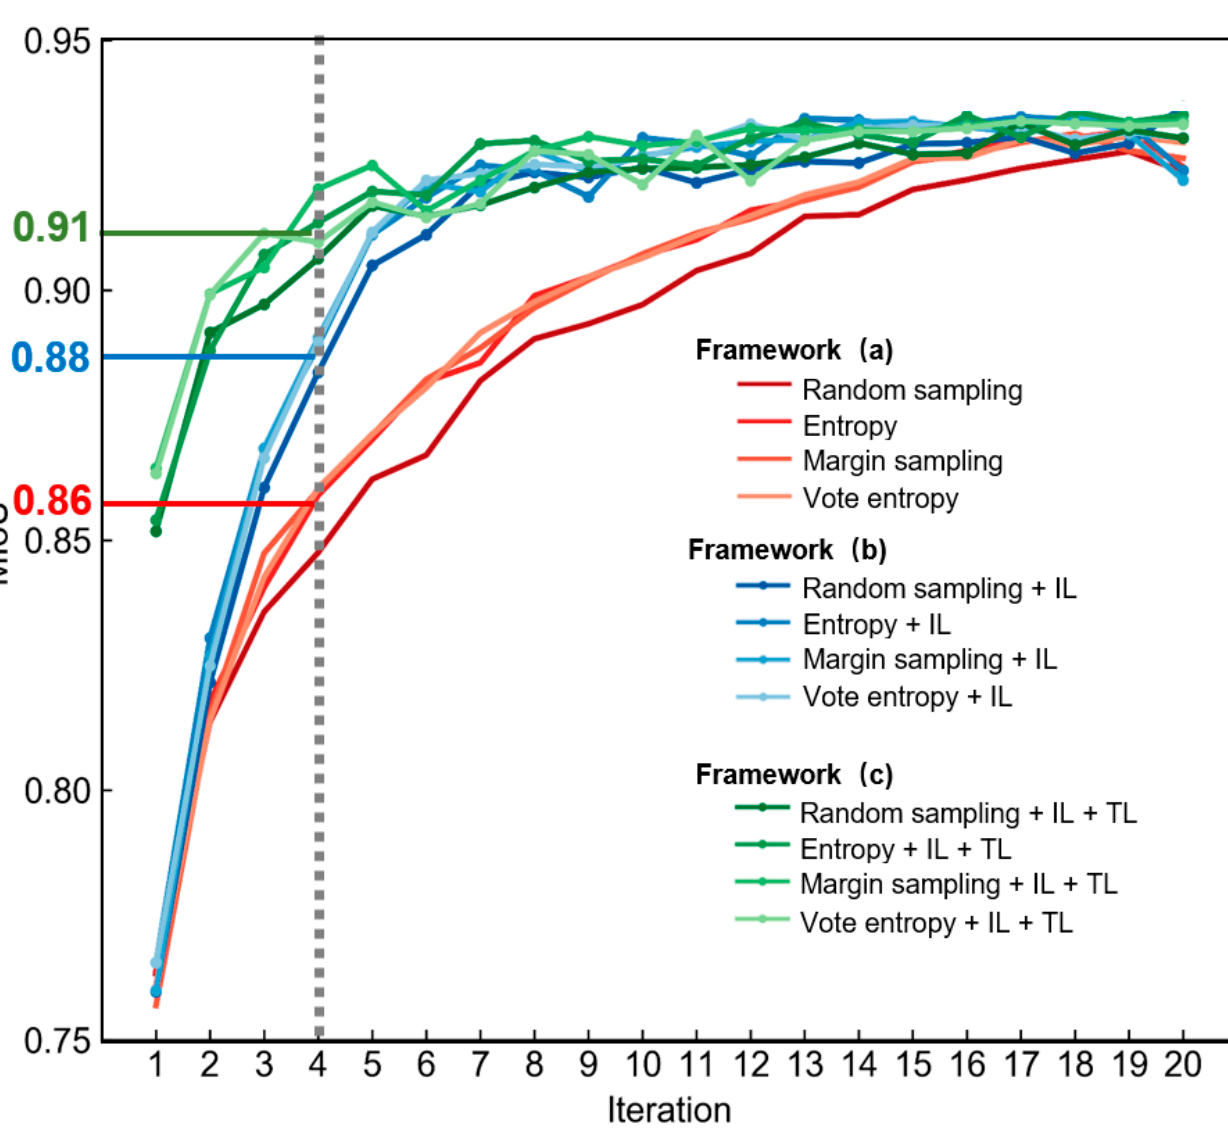
Figure 6. Comparison of performance of the three frameworks based on WHU aerial building dataset. The red lines indicate the mIoU value of DeeplabV3+ in each iteration derived from framework ( a ), the blue lines indicate the mIoU value of DeeplabV3+ in each iteration derived from framework ( b ), and the green lines indicate the mIoU value of DeeplabV3+ in each iteration derived from framework ( c ).